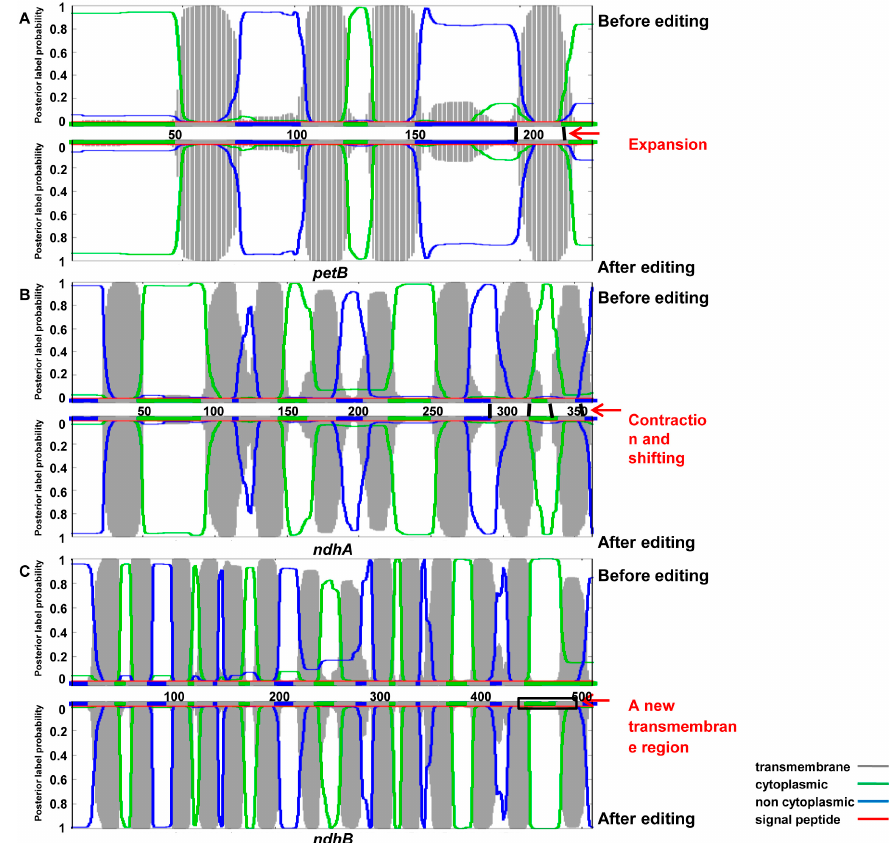
Figure 3. Transmembrane topology of petB , ndhA and ndhB before and after editing. ( A ) The transmembrane region of petB expanded to the C terminal of the protein after editing; ( B ) The transmembrane region of ndhA displayed a contraction and shift after editing; ( C ) NdhB showed a larger transmembrane region after editing.